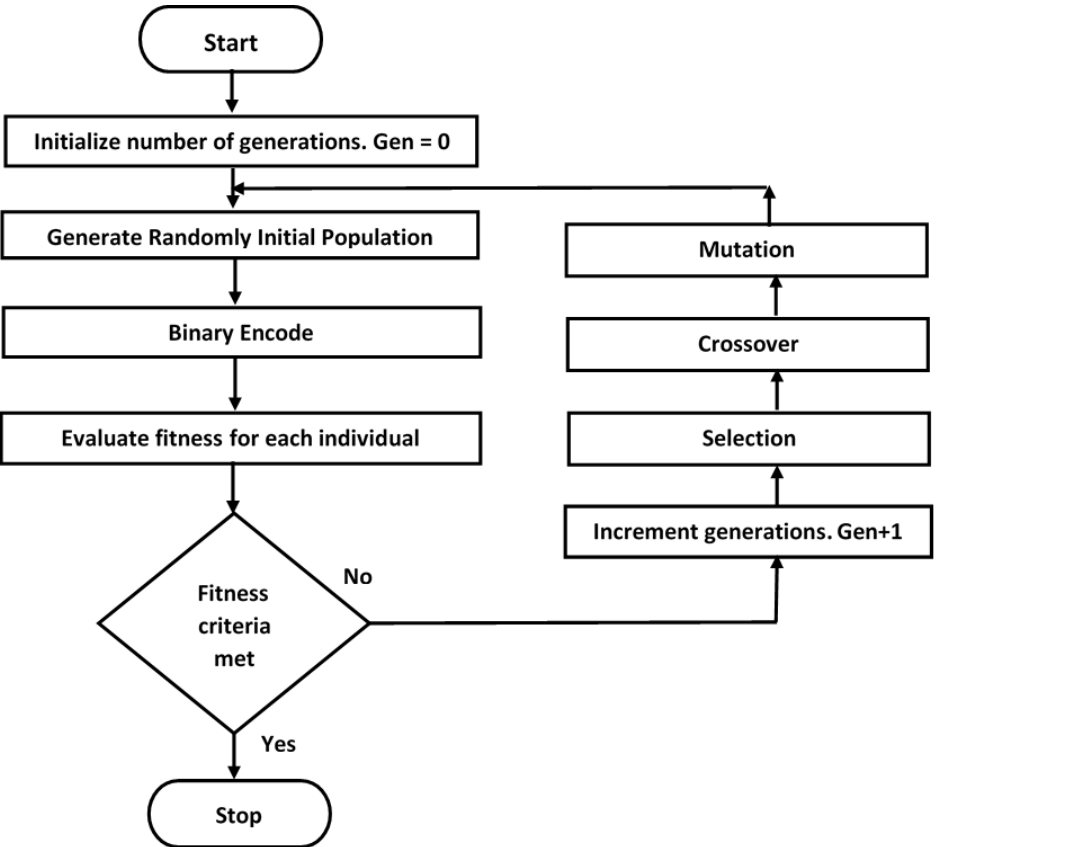
Figure 4. Flowchart of the modified